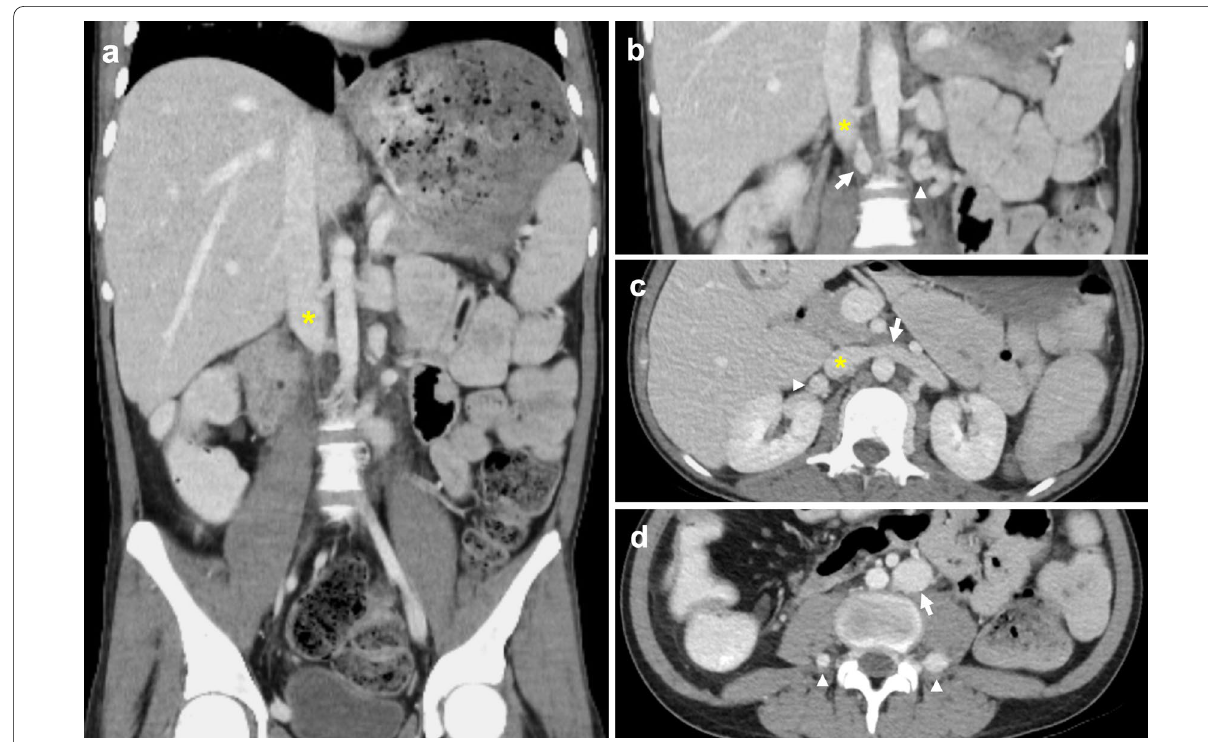
Fig. 7 Absent infrarenal IVC with azygos continuation. Paired common iliac veins continue cranially as bilateral ascending lumbar veins. a Contrast-enhanced coronal CT demonstrates the caudal end of the IVC (asterisk). b Coronal CT shows the right ascending lumbar vein (arrow) approaching and subsequently draining into the IVC (asterisk). Tortuous paravertebral collateral veins (arrowhead) are present adjacent to the aorta. c Axial CT image with left renal vein (arrow) crossing anterior to the aorta to drain into the renal IVC segment (asterisk). Right renal vein (arrowhead) also approaches renal IVC segment. d Axial CT shows prominent bilateral ascending lumbar veins (arrowheads) and a distended paravertebral collateral (arrow) positioned left of the